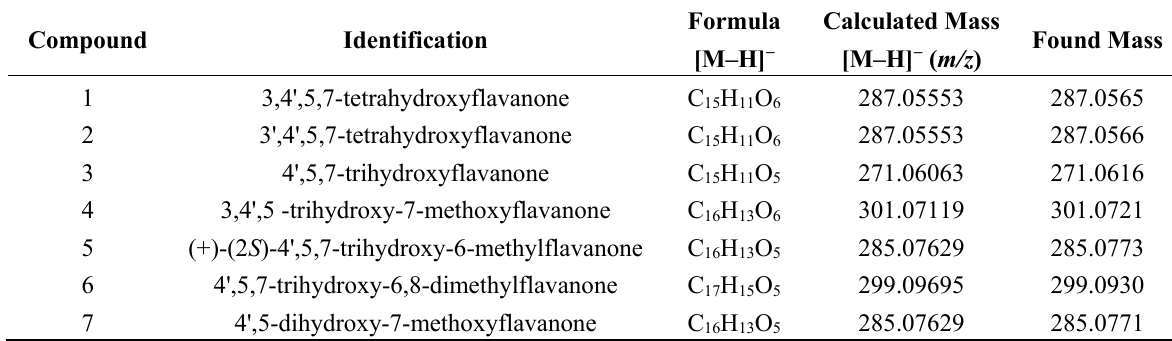
Table 4. The kino extract of Corymbia torelliana contained flavanones 1 – 7 ; analyses by